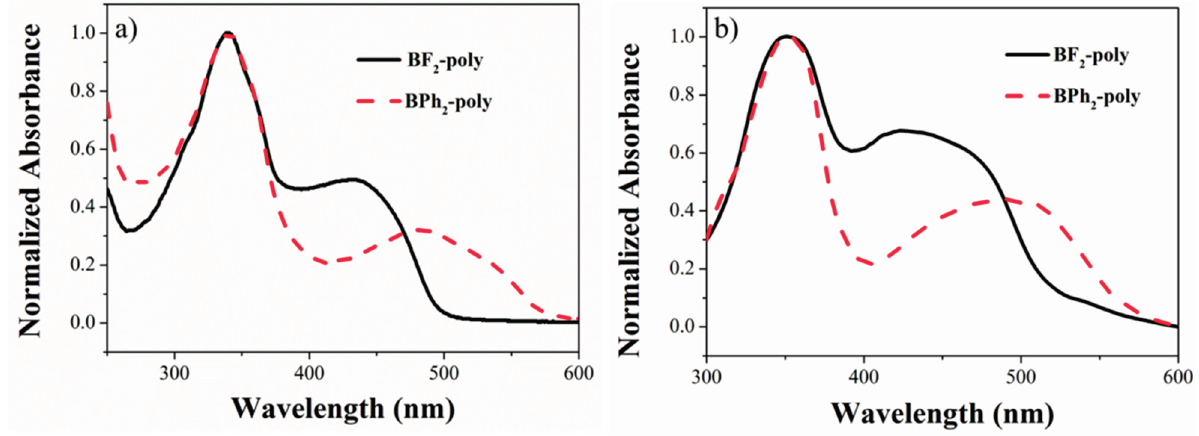
-poly and BPh -poly in CH 2 Cl 2 ( a ) and in solid 2 2